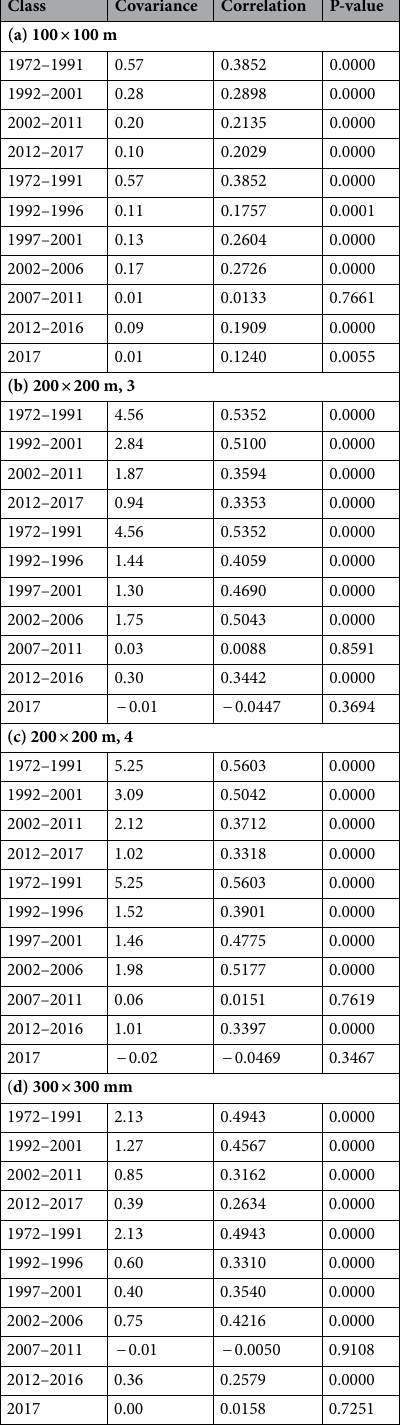
Table 3. Deterioration correlation analysis: (a) 100 × 100 m, (b) 200 × 200 m, 3, (c) 200 × 200 m, 4, (d) 300 × 300